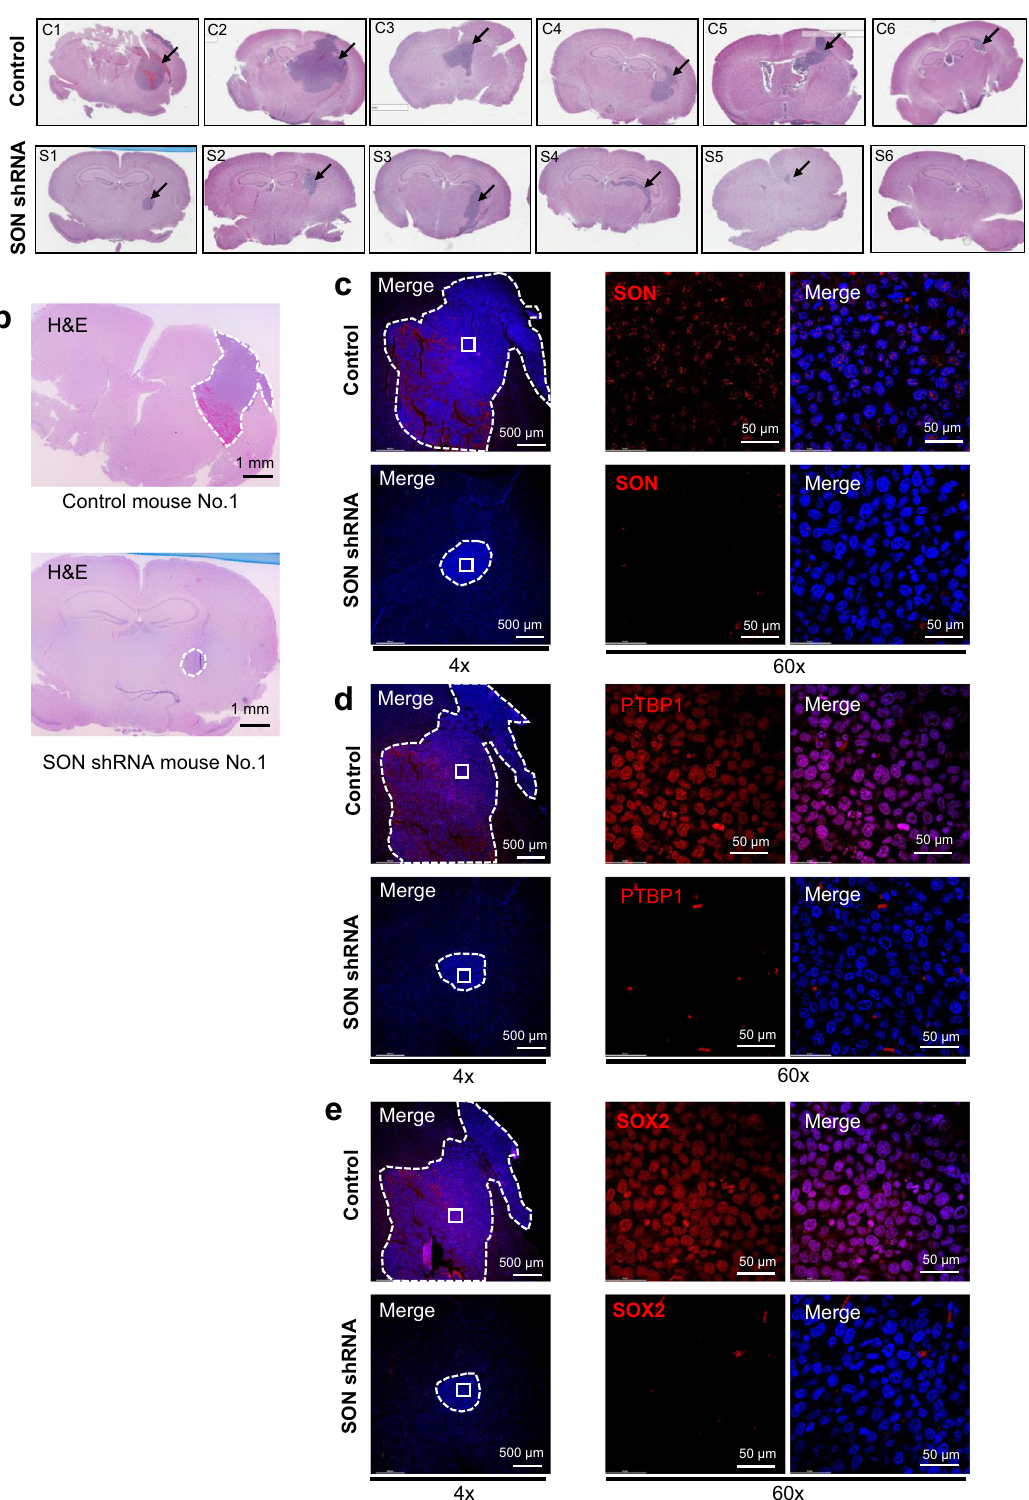
Fig. 8 SON depletion in GSCs leads to suppression of tumor growth in vivo. a Representative H&E staining images of mouse brain sections showing tumor growth (black arrows) resulting from stereotaxic injection of GSC#83 cells transduced with control or SON shRNA lentivirus ( n = 6). C1 – C6 and S1 – S6 indicate individual mice injected with control (C) and SON shRNA (S)-transduced GSC#83. b H&E sections that were closest to the sections used for immuno fl uorescence staining in panel ( c – e ). Areas marked with dotted lines indicate the tumors. c – e Representative immuno fl uorescence staining images of SON ( c ), PTBP1 ( d ), and SOX2 ( e ) (red) together with DAPI (blue) were shown for the tumor formed by GSCs expressing control or SON shRNA ( n = 4). Dotted lines indicate the tumor and the area within the square (marked with while solid lines) was used for 60× imaging shown in ( c – e ). Scale bar: H&E: 1 mm, 4×: 500 μ m, and 60×: 50 μ